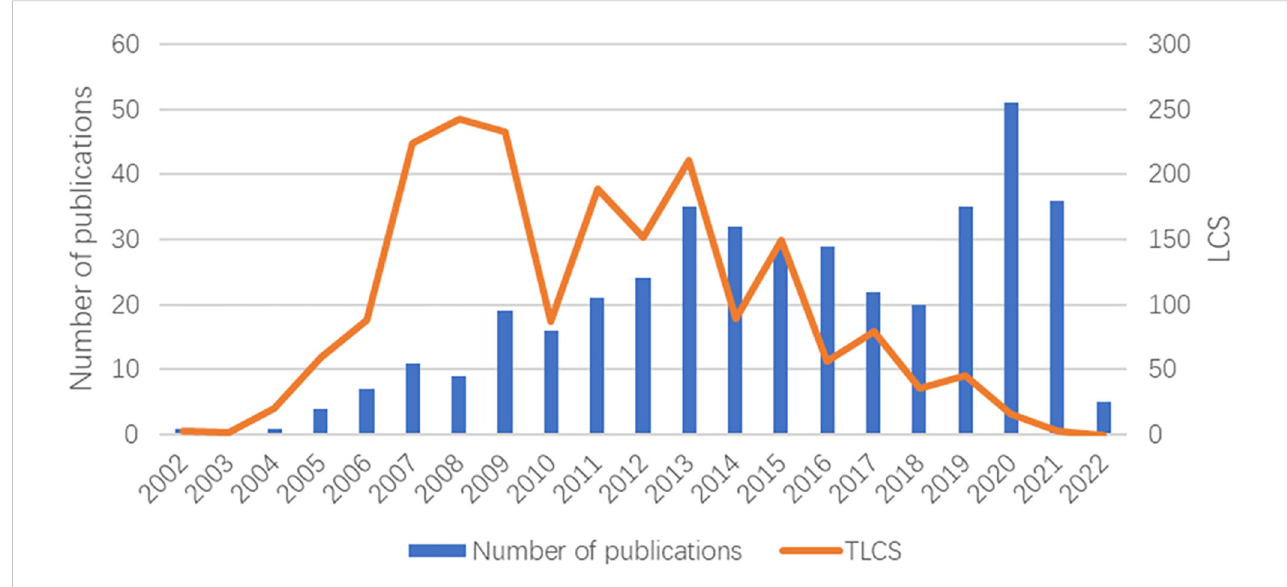
FIGURE 1 The number of publications and LCS by year over the past 20 years.